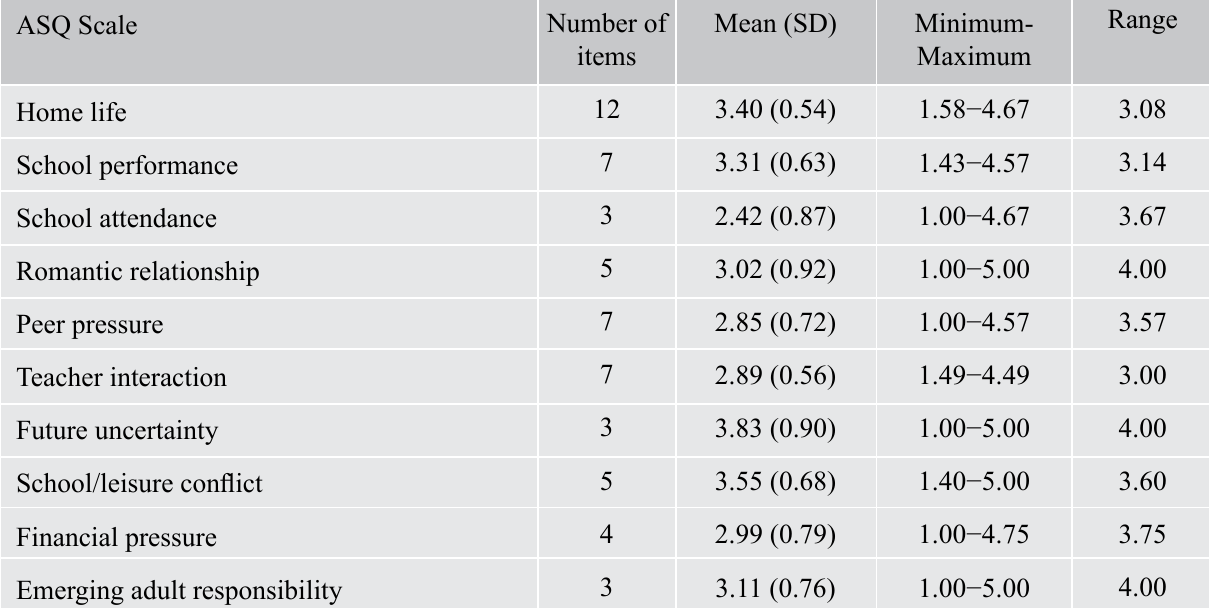
Table II: Descriptive statistics of ASQ scale (N=278)